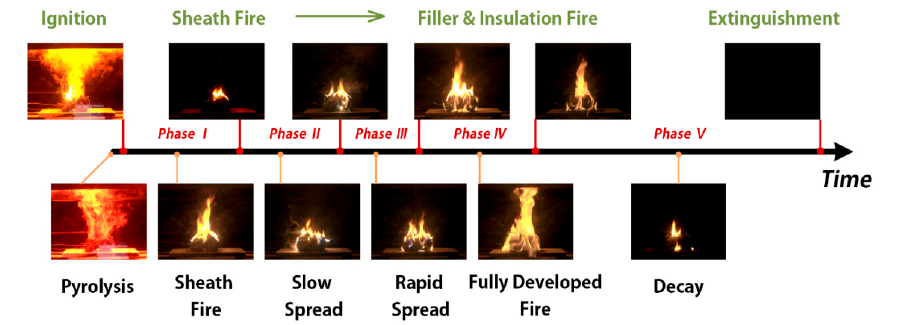
Figure 10. Snapshots of different phases during Test 2. Table 3. Descriptions of different phases during the cable burning process in Test 2.